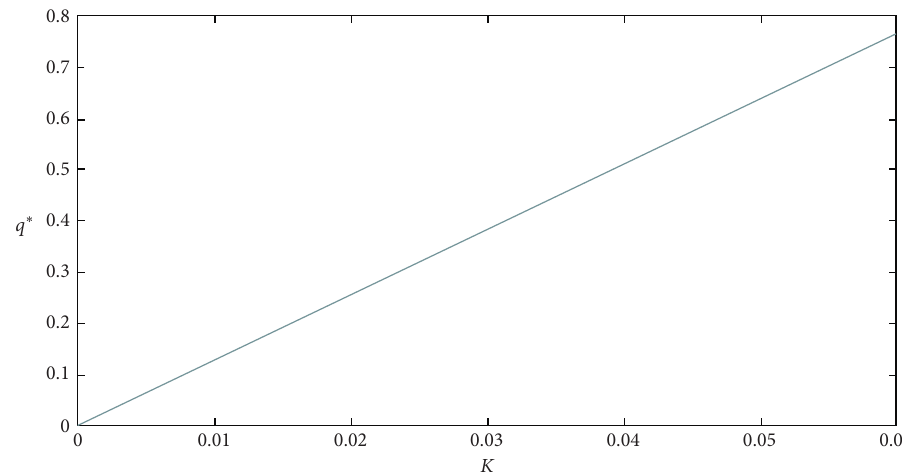
Figure 9: Simulation diagram of the influence of supervision cost on the optimal rent-seeking